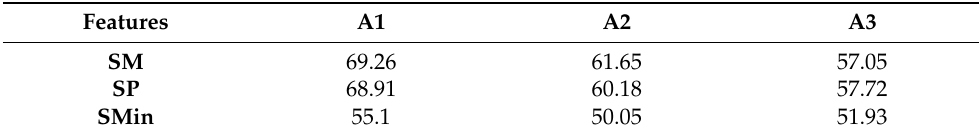
Table 3. Offline classification accuracies of three amputee subjects using single features signal mean (SM), signal peak (SP), signal minimum (SMin), and waveform length features for EMG and fNIRS using LDA and ANN Classifiers.